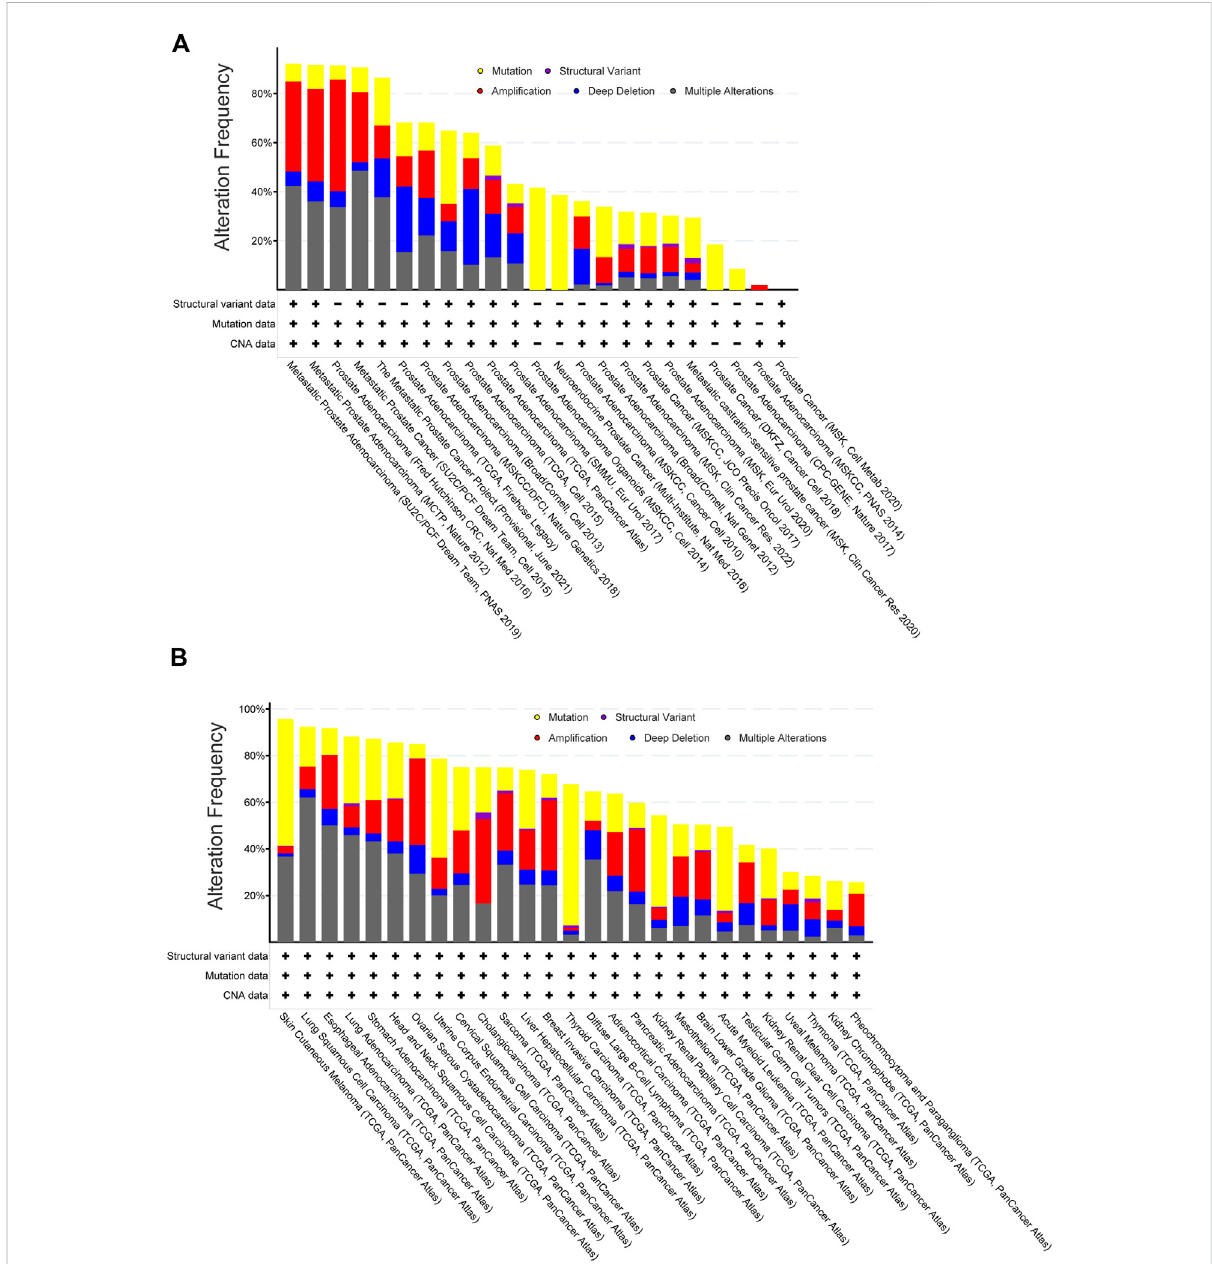
FIGURE 2 Target genes of PC-3-speci fi c nuclear-size rectifying compounds [NSRs, predicted in Tollis et al. (2022)] are more often altered in metastatic prostatecancersthanothercancers. (A) FrequencyofgeneticalterationsintargetsofPC-3-speci fi cNSRsacrossarangeofprostatecancerdatasets (data retrieved from TCGA database, manually curated non-overlapping prostate cancer datasets). Shown are gene mutations (yellow), structural variants (purple), ampli fi cation (red), deletion (blue) or multiple alterations. Metastatic cancers (left bars) show more alterations than non- metastatic cancers (right bars). (B) Frequency of genetic alterations in targets of PC-3-speci fi c NSRs across a range of cancer types (data retrieved from TCGA PanCancer Atlas database, from which bladder and colorectal adenocarcinoma and multiform gliomas have been excluded due to dataset size limitations). Note that comparison between cancer types (TCGA PanCancer Atlas data) did not allow for restricting to non-overlapping datasets and so these data are not directly comparable with panel (A) . Shown are gene mutations (yellow), structural variants (purple), ampli fi cation (red), deletion (blue) or multiple